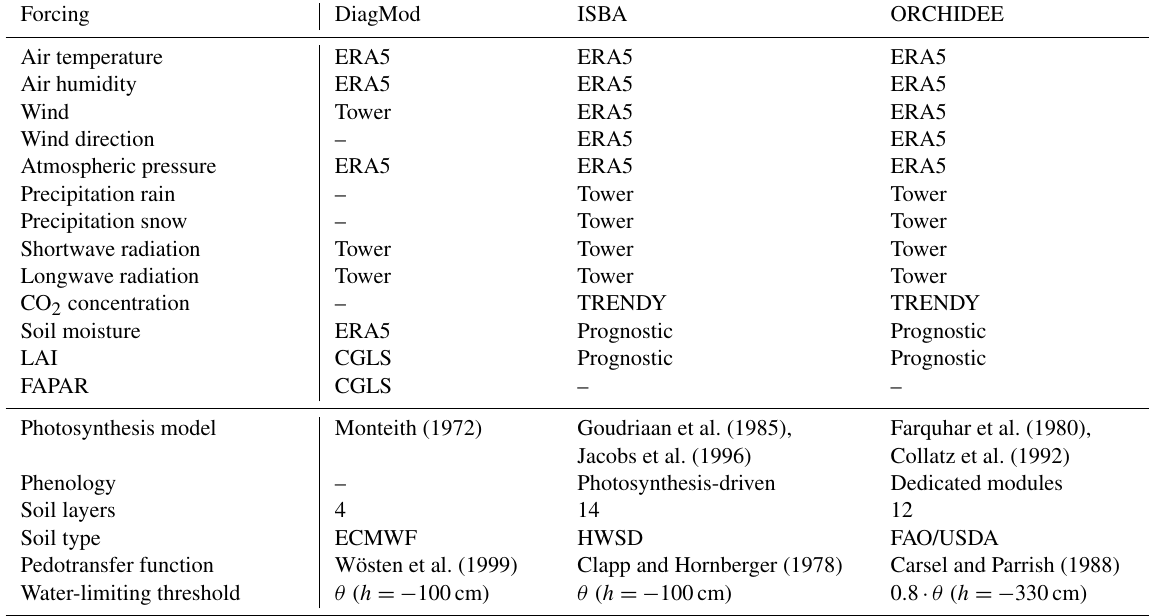
Table 1. Source of forcing variables. Tower: flux tower observations from FLUXNET2015 dataset (Pastorello et al., 2020) and the ICOS “2018 drought initiative” dataset (Drought 2018 Team and ICOS Ecosystem Thematic Centre, 2019); TRENDY (Sitch et al., 2015; https: //sites.exeter.ac.uk/trendy, last access: 15 July 2022); CGLS: Copernicus Global Land Service (Camacho et al., 2013); ECMWF: soil texture used in the ECMWF Integrated Forecast System (https://apps.ecmwf.int/codes/grib/param-db?id=43, last access: 15 July 2022); HWSD: harmonized world soil database (Nachtergaele et al., 2010); FAO/USDA: USDA texture map based on FAO digital Soil Map of the World (Reynolds et al., 2000). θ ( h = − 100cm) refers to the water content at matric head, which equals − 100cm, derived from the water retention